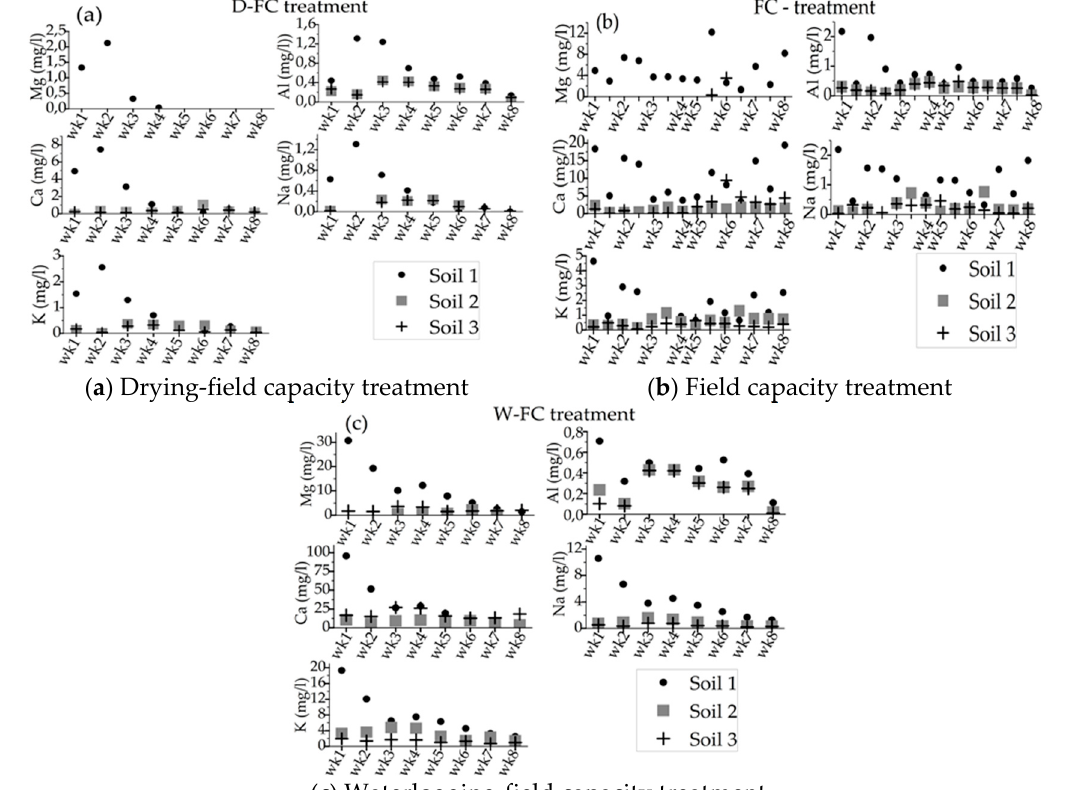
Figure 10. The concentration of cations determined using the Inductivity Coupled Plasma-Optical Emission Spectrometry Instruments (ICP-OES) technique at the drying- field capacity ( a ), field capacity ( b ), and waterlogging- field capacity ( c ) treatments for Soil 1–Soil 3. While the results were every week for the D-FC and the W-FC treatments, the results were at three days basis for the FC treatment.